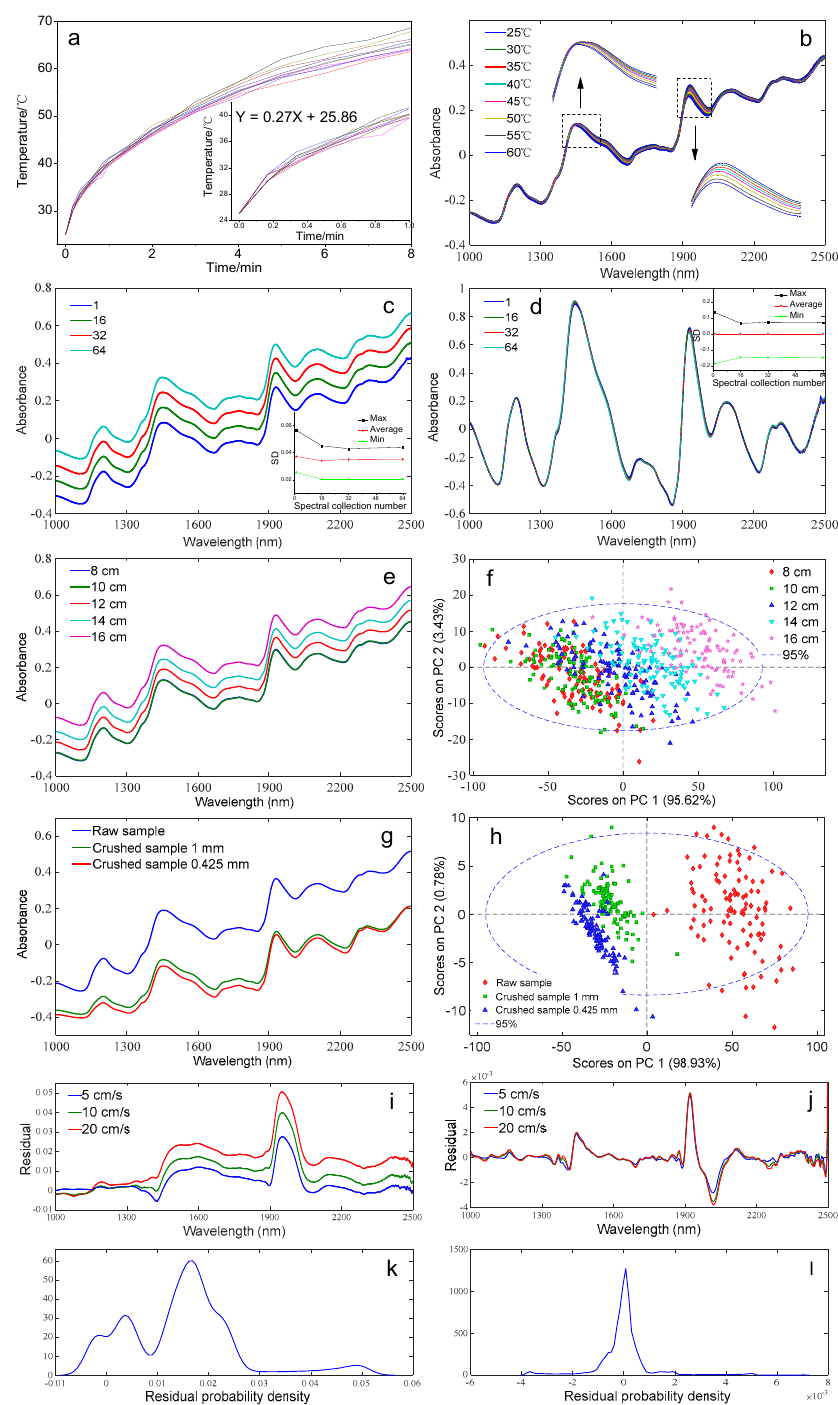
Figure 1. NIR results at different sample surface temperatures, number of scans, detection optical paths, particle sizes, and conveyor speeds (( a ) the variation of surface temperature of the forage maize against the scanning time; ( b ) NIR spectra of the forage maize at different temperatures; ( c , d ) NIR spectra ( SD values) of the forage maize with different number of scans without and with SNV and detrend preprocessing; ( e , f ) NIR spectra and PCA result of the forage maize with different detection optical path; ( g , h ) NIR spectra and PCA result of the forage maize with different particle sizes; ( i − l ) the residual distribution and residual probability density distribution without and with SNV +detrend +first derivative preprocessing).